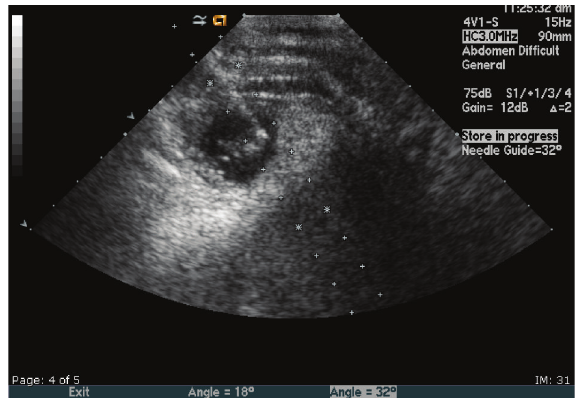
Figure 3: Intralesion injection of the gestational sac using a guided